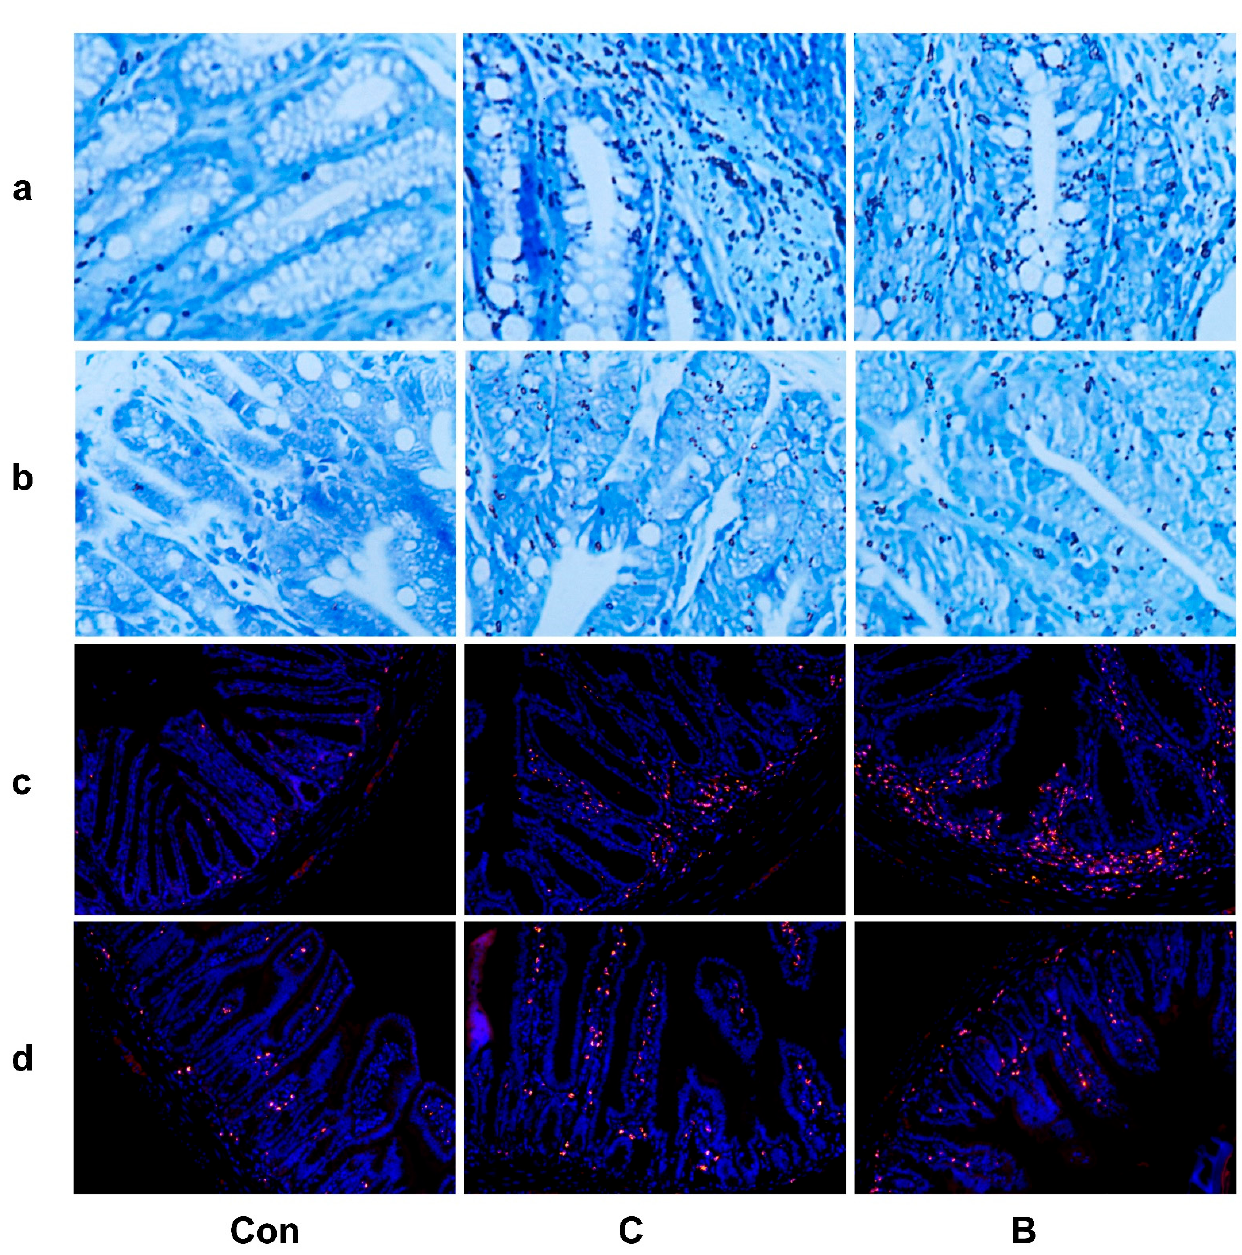
Figure 6. Groups with long-term administration of DSS (group C) and groups with 7-day administration of 3% DSS (group B) both exhibit mast cell and neutrophil infiltration. ( a ) TB colon staining (400 × magnification); ( b ) TB small intestine staining (400 × magnification); ( c ) representative images of MPO expression in colon tissue; ( d ) representative images of MPO expression in small intestine tissue. Mast cells in the small intestine and colon tissue are stained purple. MPO protein in small intestine and colon tissue is detected by immunohistochemical methods; positive cells are stained in red, and MPO-positive cells represent neutrophils.